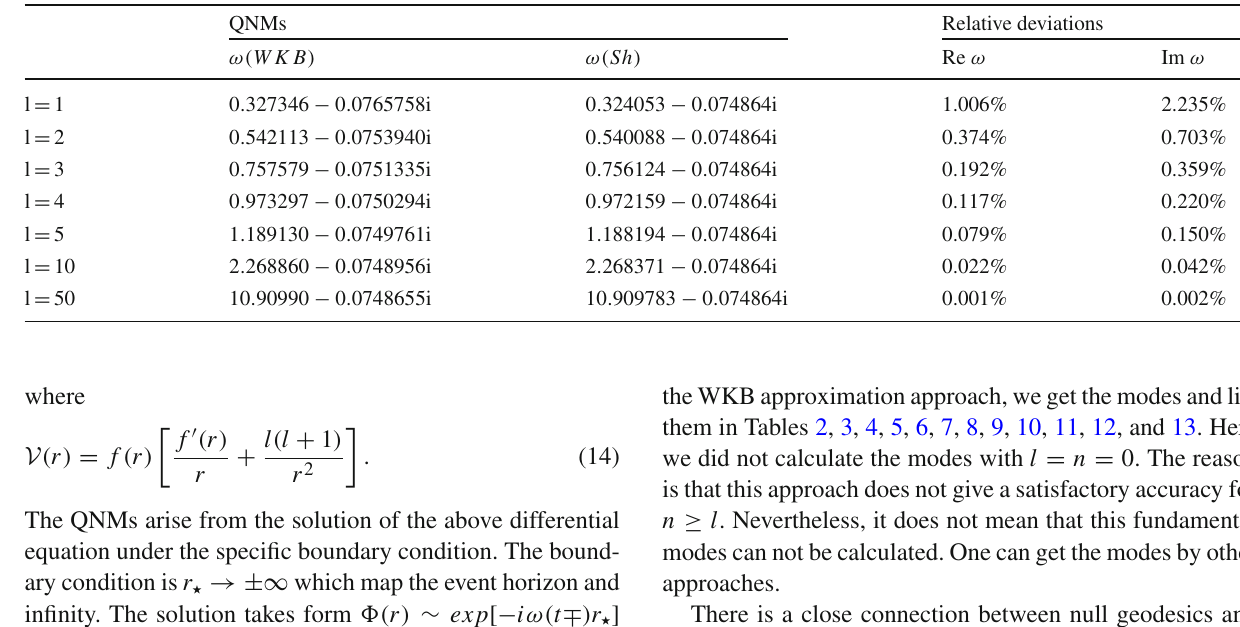
Table 7 The QNMs derived by the WKB approximation approach and shadow radius and the relative deviations. In the calculation, we let Q = 0 . 4 and α = 0 .